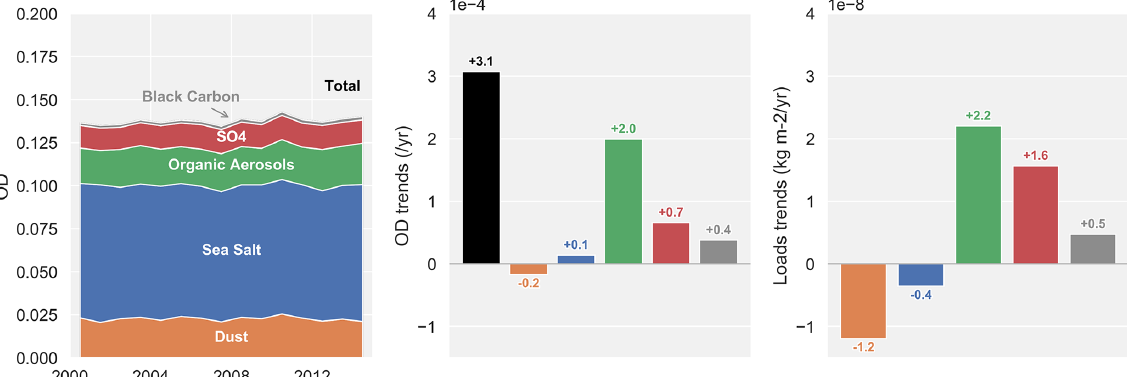
Figure 8. Absolute trends in OD and emissions of the main aerosol species computed with NorESM2. The y axis of the trends in OD and the emissions is given according to the power of 10 indicated at the top left corner of each of the